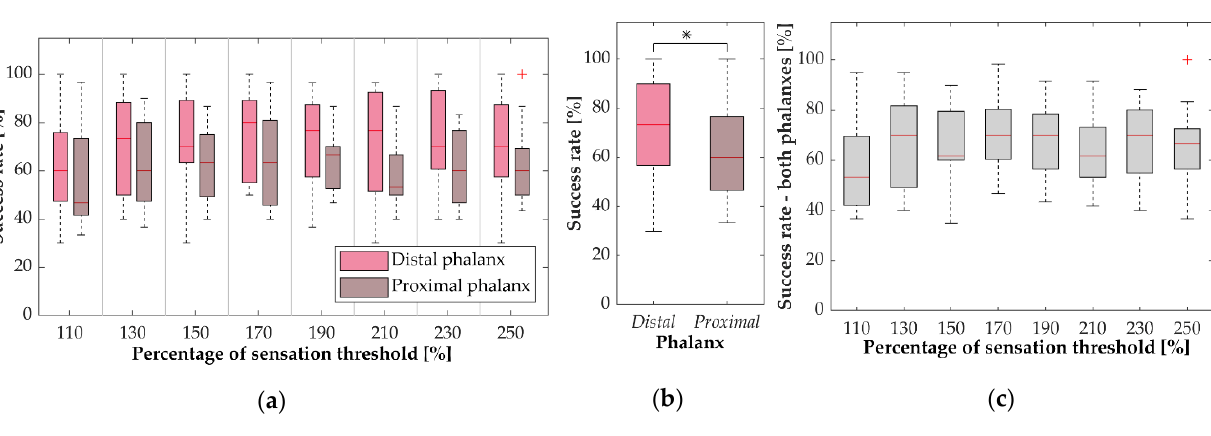
Figure 4. ( a ) Success rate in spatial discrimination obtained for different current amplitudes for the distal phalanx (pink) and proximal phalanx (brown); ( b ) Main effect of phalanx—the success rate for each phalange averaged across current amplitude levels; ( c ) Main effect of current amplitude—success rate for each current amplitude level averaged across the two phalanges. The red line, box, whiskers and red mark indicate the median, interquartile range upper/lower boundaries and outlier, respectively. Asterisks indicate significant differences (*: p < 0.05).